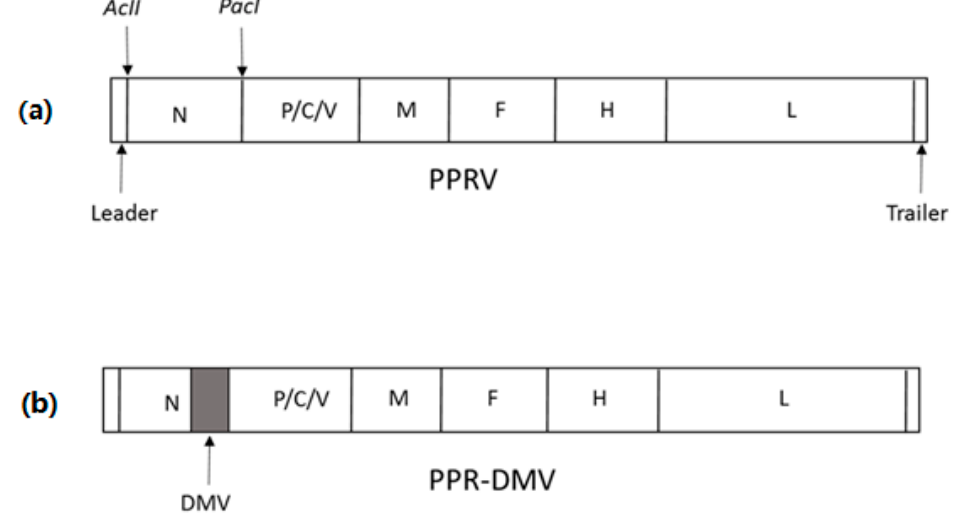
Figure 1. Schematic showing the genome of the PPRV ( A ) and PPR–DIVA ( B ) viruses (not to scale). The parental PPRV is shown in ( A ), indicating the unique restriction sites used for the construction of PPR–DIVA cDNA. The shaded box ( B ) represent the gene from DMV.